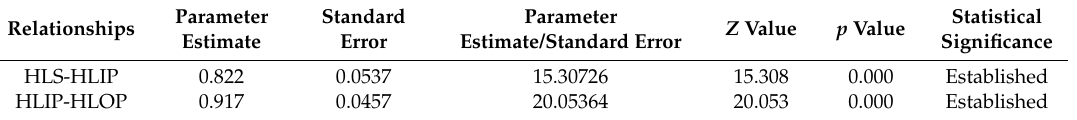
Table 13. Parameter estimates for statistical significance (Source: LISREL